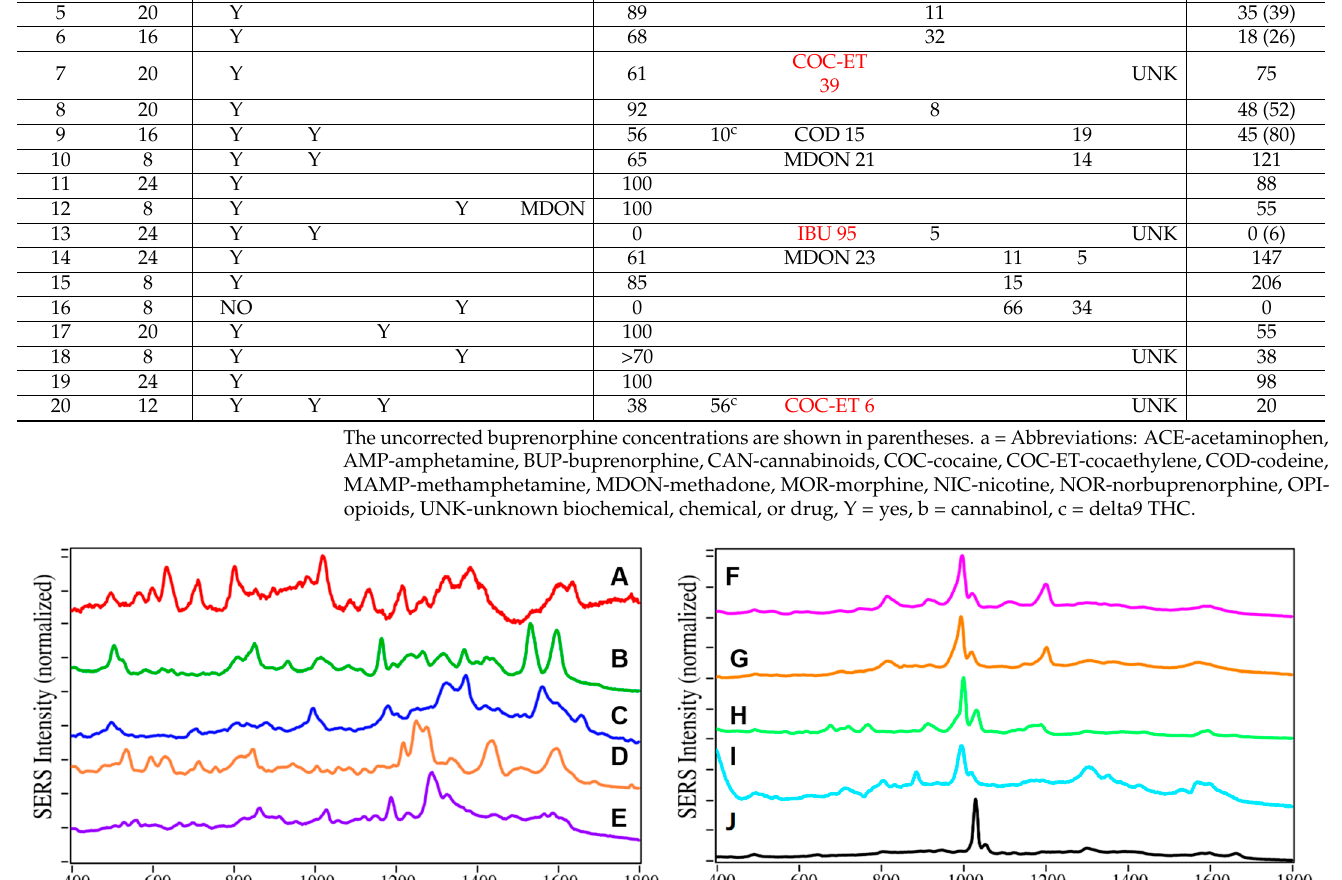
Figure 3. SERS of drugs other than buprenorphine identified in the various samples: ( A ) norbupren- orphine, ( B ) acetaminophen, ( C ) ibuprofen, ( D ) codeine, ( E ) cannabidiol, ( F ) amphetamine, ( G ) methamphetamine, ( H ) methadone, ( I ) cocaethylene, and ( J ) nicotine. All samples measured at 100 µg/mL in water. Conditions as in Figure 1.